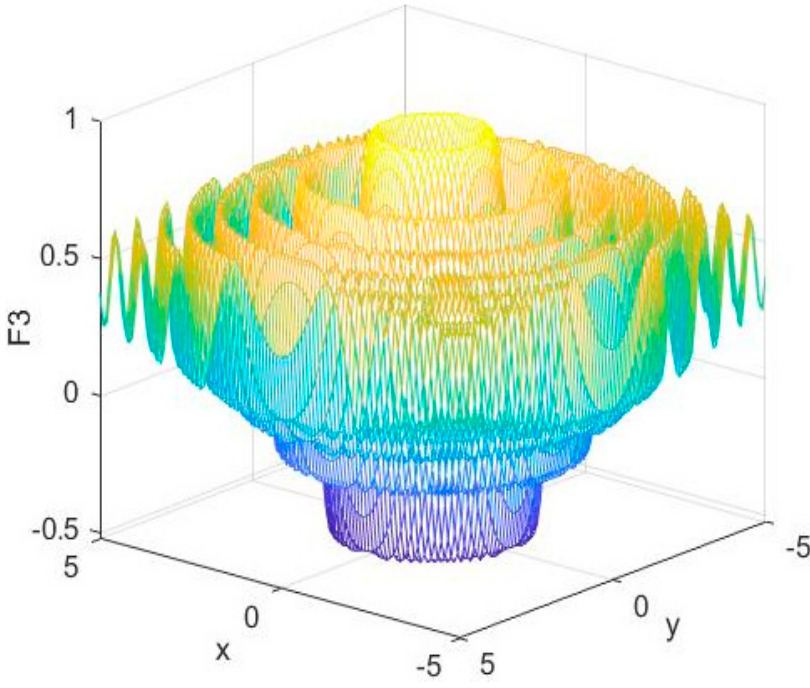
Figure 13. Second-used test function.